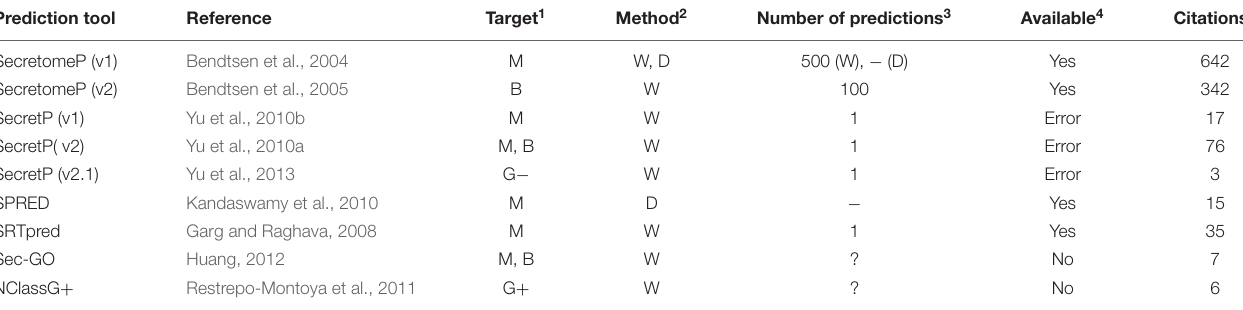
TABLE 1 | Details of non-classically secreted protein (CSP) prediction programs, as of April 2016. Prediction